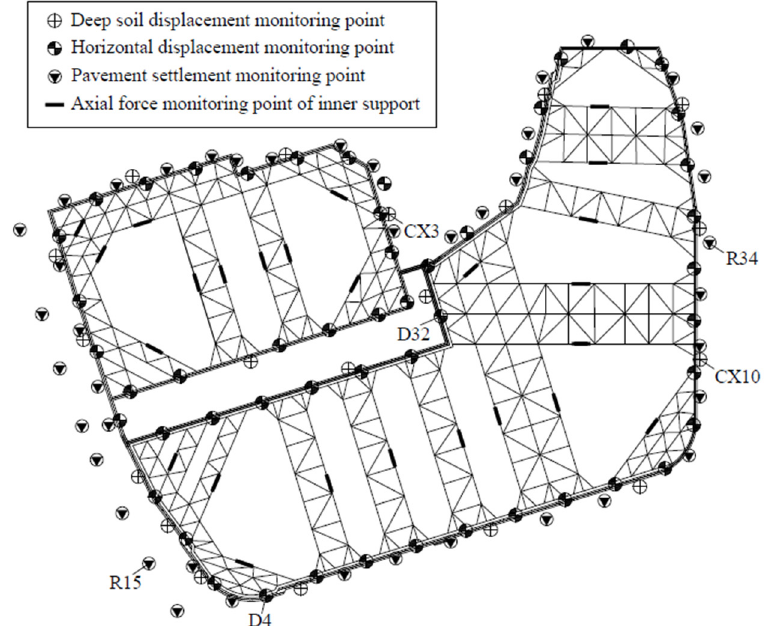
Figure 5. Monitoring point